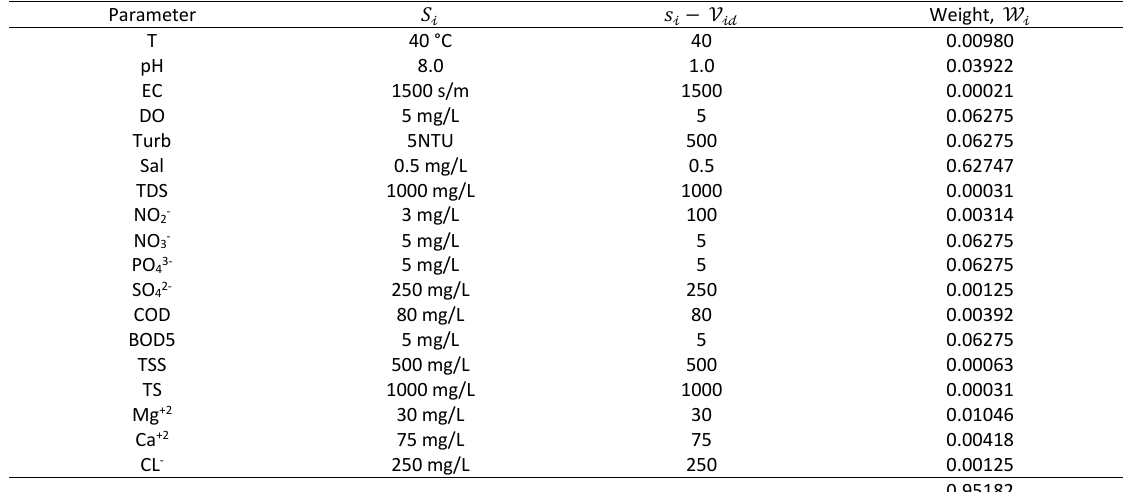
Table 4: Calculaon of numerator and denominator of unit weight Table 4: Calculation of numerator and denominator of unit weight